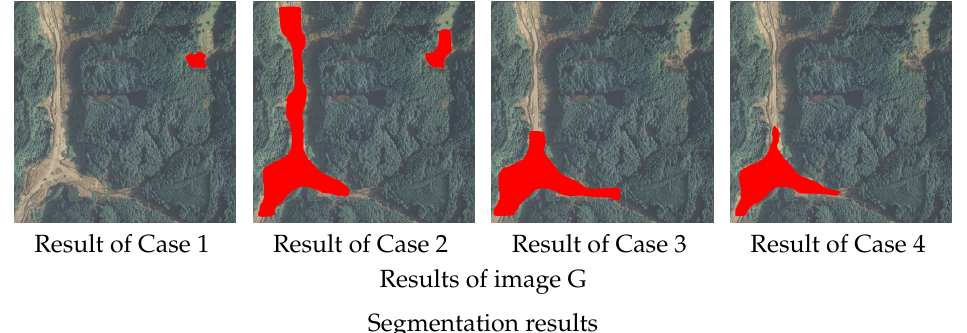
Figure 6. Segmentation results (Examples of Cases 2, 3, 4, and 1 detected correctly in that order). The images in the first and second lines show the original aerial photographs and the ground truth, which indicates the area of slope failure regions in red in the aerial photograph, respectively. The images in the third to fourth lines show the results of detecting slope failure regions for images F and G shown in the first line, respectively. The detection results are shown in the order of Case 1, 2, 3, and 4 from the left to right. Case 2 is generally detected correctly in most cases, while the other cases have more detection omissions in the order of case 3, 4, and 1.